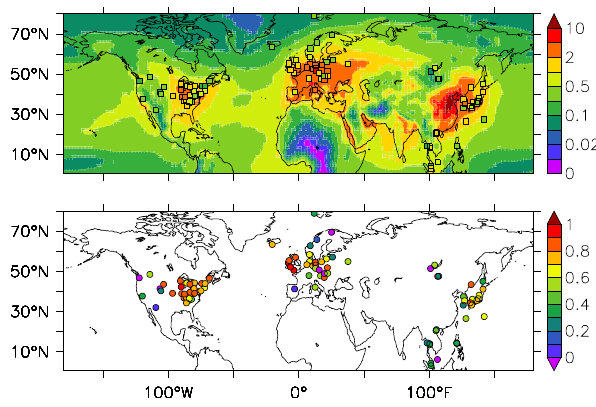
Fig. 7. As Fig. 5 but for NO −